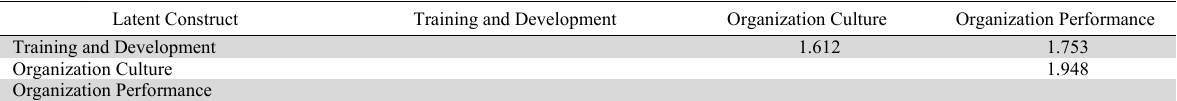
Summary of outer VIF across